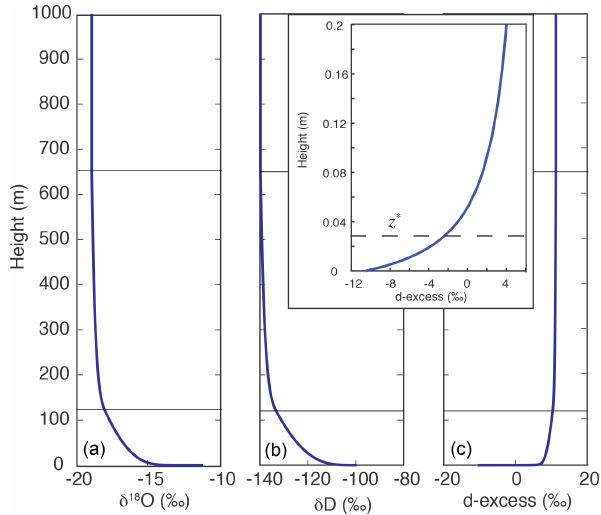
Figure 3. Model simulation of vertical distributions of δ 18 O (a) , δ D (b) , and d-excess (c) . Parameters are SST = 5 ◦ C, K max = 0 . 1m 2 s − 1 , h 1 = 120m, r E = 0 . 5gkg − 1 , w a = 0 . 15ms − 1 , and β = 0 . 05, and δ 18 O, δ D, and d-excess of subsiding air are − 33‰, − 239‰, and 25‰, respectively. The horizontal solid lines mark the heights of h 1 and h 2 (120 and 650m). The inset graph shows d-excess variation with height in the 20cm just above the sea sur- face. The dashed line marks the value of z ∗ (0.027m), below which molecular diffusion is more significant than turbulent